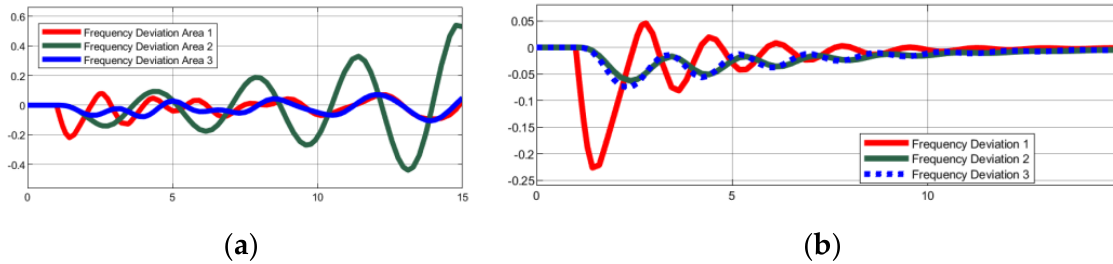
Figure 11. ( a ) Frequency Deviations, Case 3. ( b ) Frequency Deviations, Case 4.